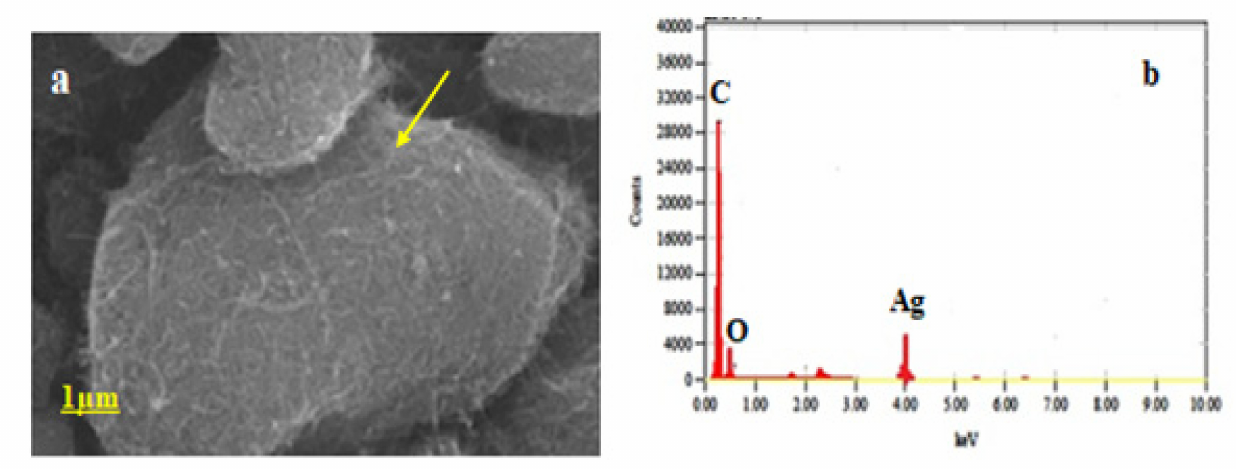
Figure 3. ( a ) FE-SEM of C 60 -AgNPs nano-composite viewed from the topical angle (shown by arrow); ( b ) EDAX of C 60 -AgNPs composite indicating the presence of elemental Silver (Ag), Carbon (C), and Oxygen (O) groups,